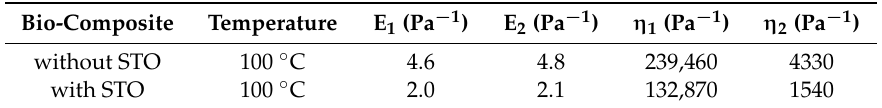
Figure 21. ( a ) Maxwell model and ( b ) Kelvin–Voigt model. Table 1. Burger coefficients for the bio-composites without STO nanoparticles and containing 20 wt. % STO nanoparticles.